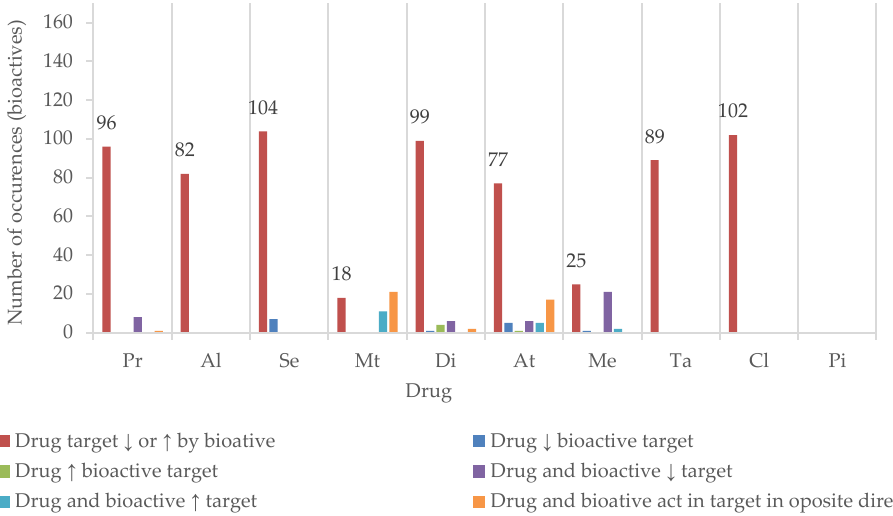
Figure 8. Number of bioactives sharing at least one target with the drugs ( ↓ —inhibition; ↑ —induction). Propranolol (Pr), alprazolam (Al), sertraline (Se), metformin (Mt), diclofenac (Di), atorvastatin (At), tadalafil (Ta), memantine (Me), piracetam (Pi), and clopidogrel (Cl).